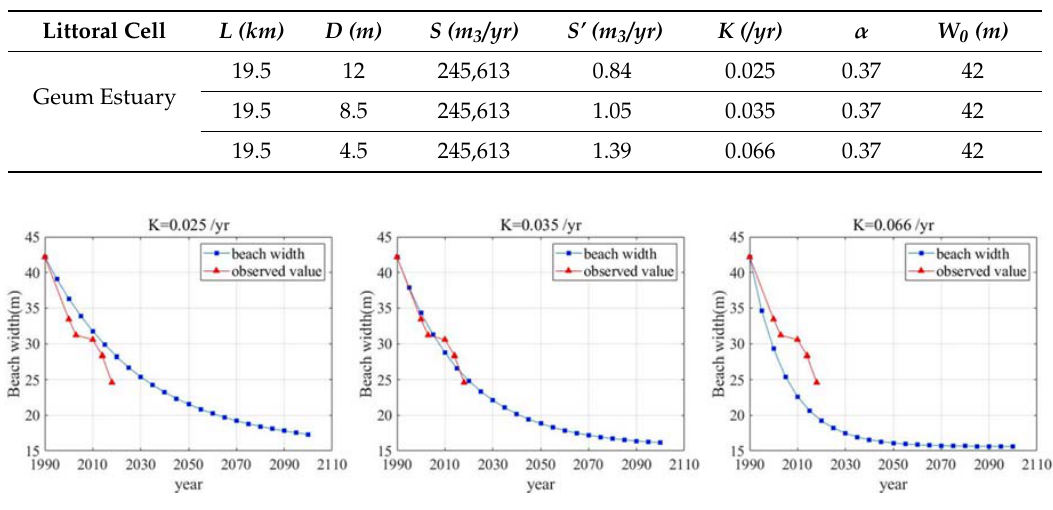
Figure 18. Parametric sensitivity analysis for coastal sediment loss rate ( 𝐾 ).